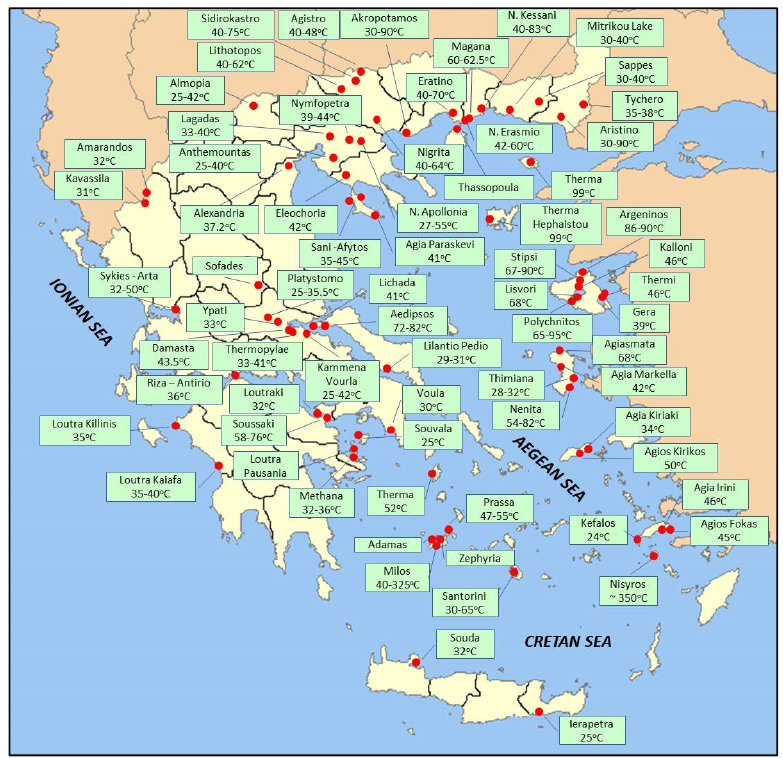
Figure 4. Geographic coverage of Greece’s geothermal fields (Source: [37]).